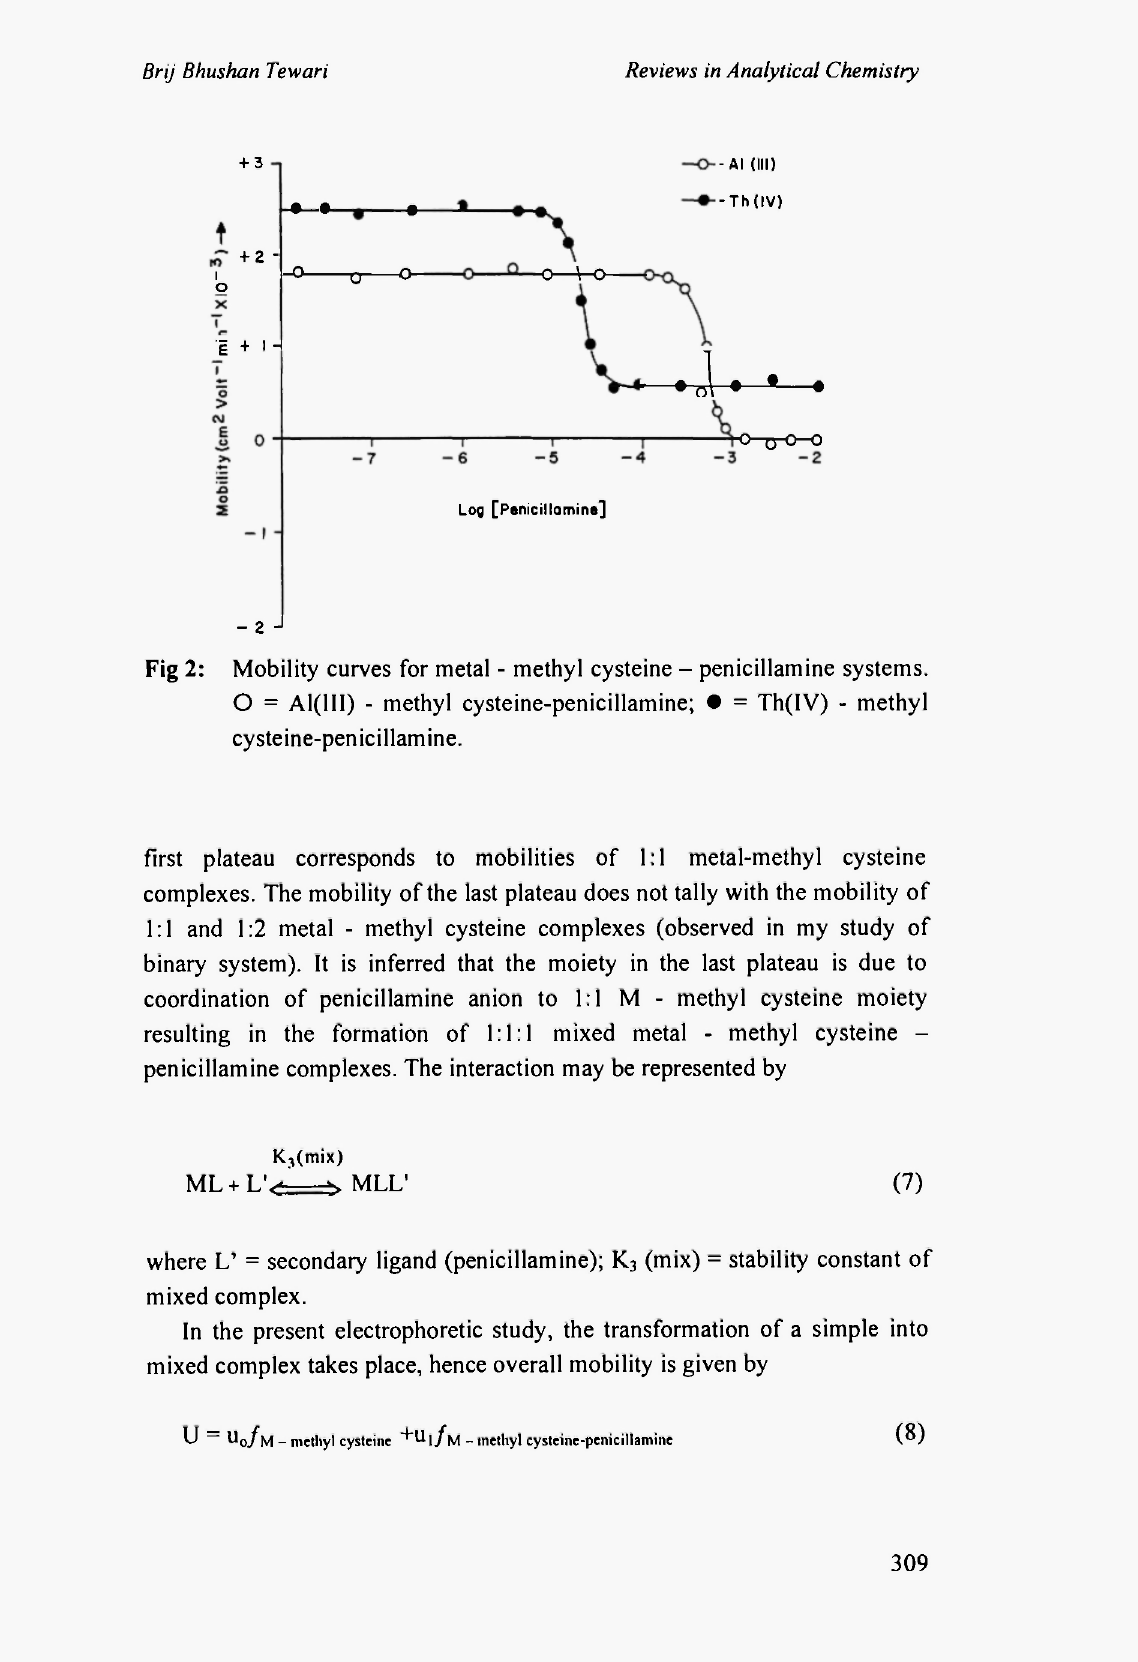
Fig 2: Mobility curves for metal - methyl cysteine - penicillamine systems. Ο = Al(lII) - methyl cysteine-penicillamine; · = Th(IV) - methyl cysteine-penicillamine.